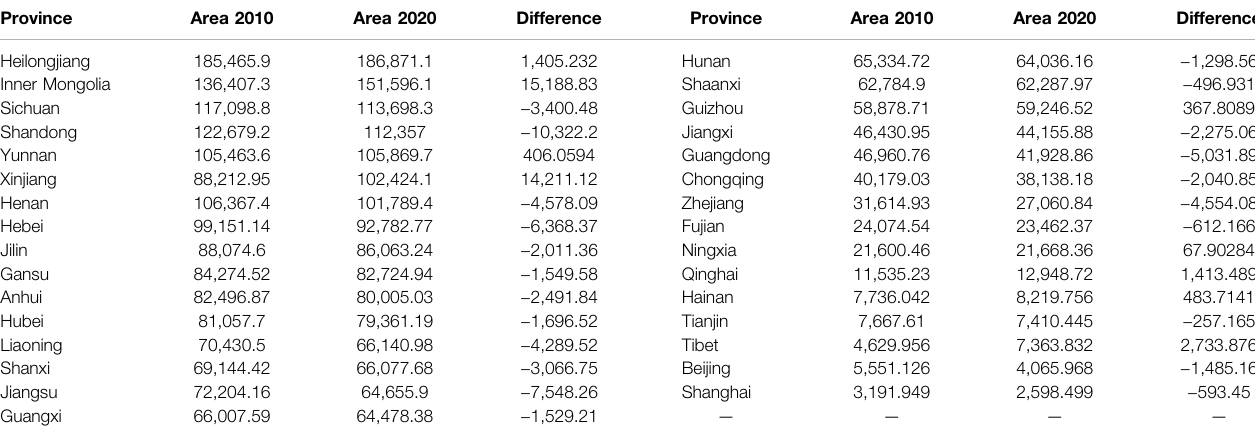
TABLE 1 | The area of cultivated land resources of 31 regions in China during 2010 – 2020 (km 2 ). Province